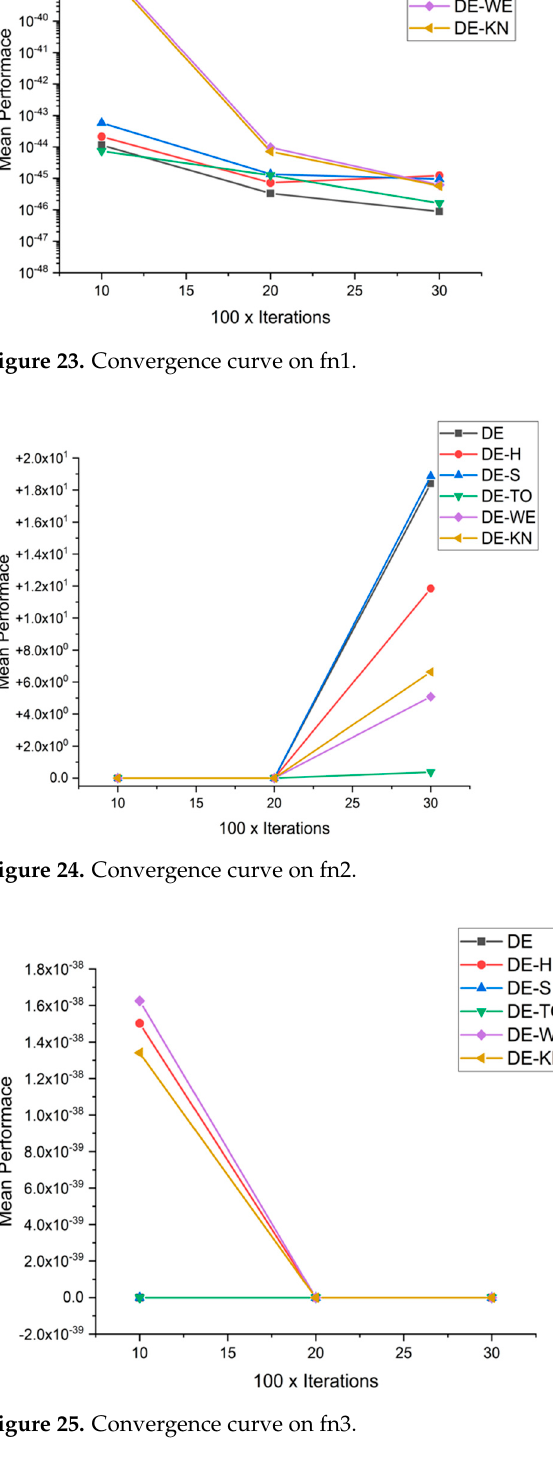
Figure 26. Convergence curve on fn4. Figure 27. Convergence curve on fn5.